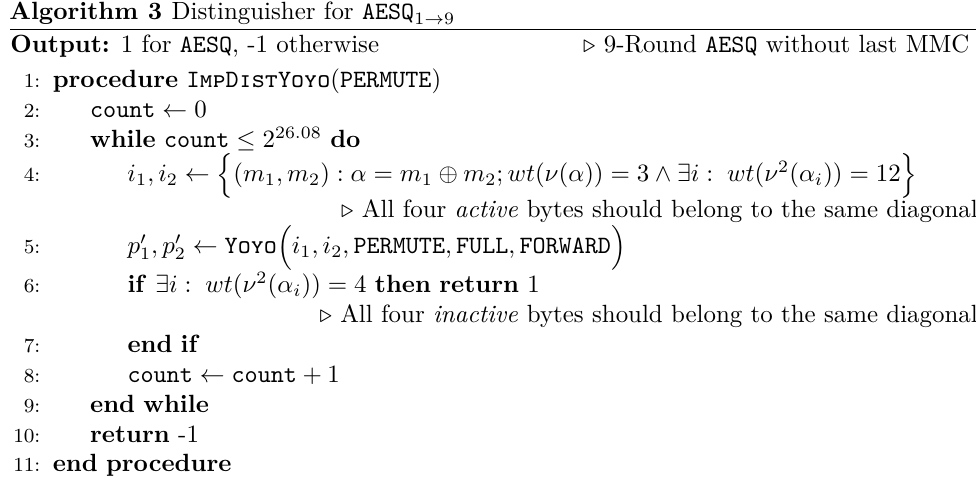
Algorithm 3 Distinguisher for AESQ